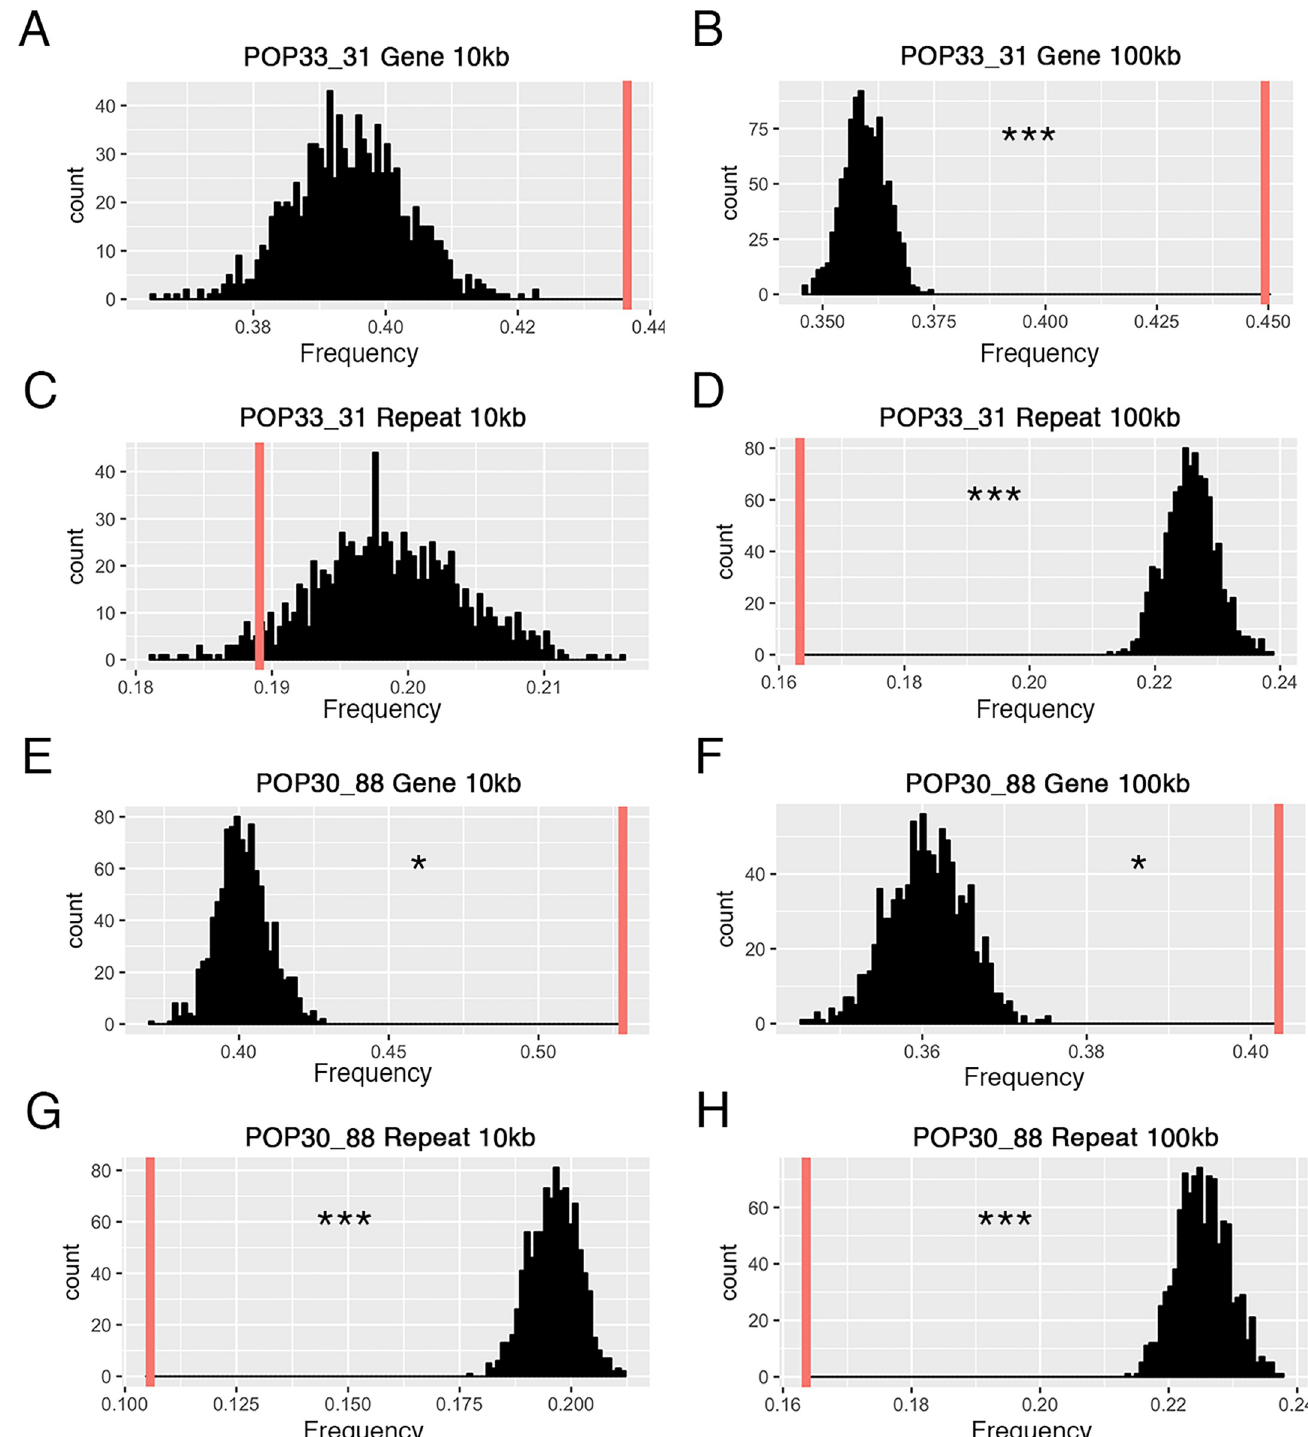
Fig 7. Sequence context surrounding the breakpoints of novel DNA junctions. The frequency of genes and repeated elements surrounding novel junctions is compared to the corresponding frequencies in randomly selected pseudo junctions. For each panel: 1,000 pseudo-junction were selected at random and the mean percentage of gene or TE space in these 1,000 junctions was calculated. This process was repeated 1,000 times and the distribution of these means are represented in black. The red vertical line represents the mean of enriched frequency for the observed validated novel junctions. Breakpoints of novel junctions in POP33_31 (A-D) occur significantly in gene-rich, repeats-deficient regions under 100kb window size (p-value < 0.001), but do not show statistical significance in